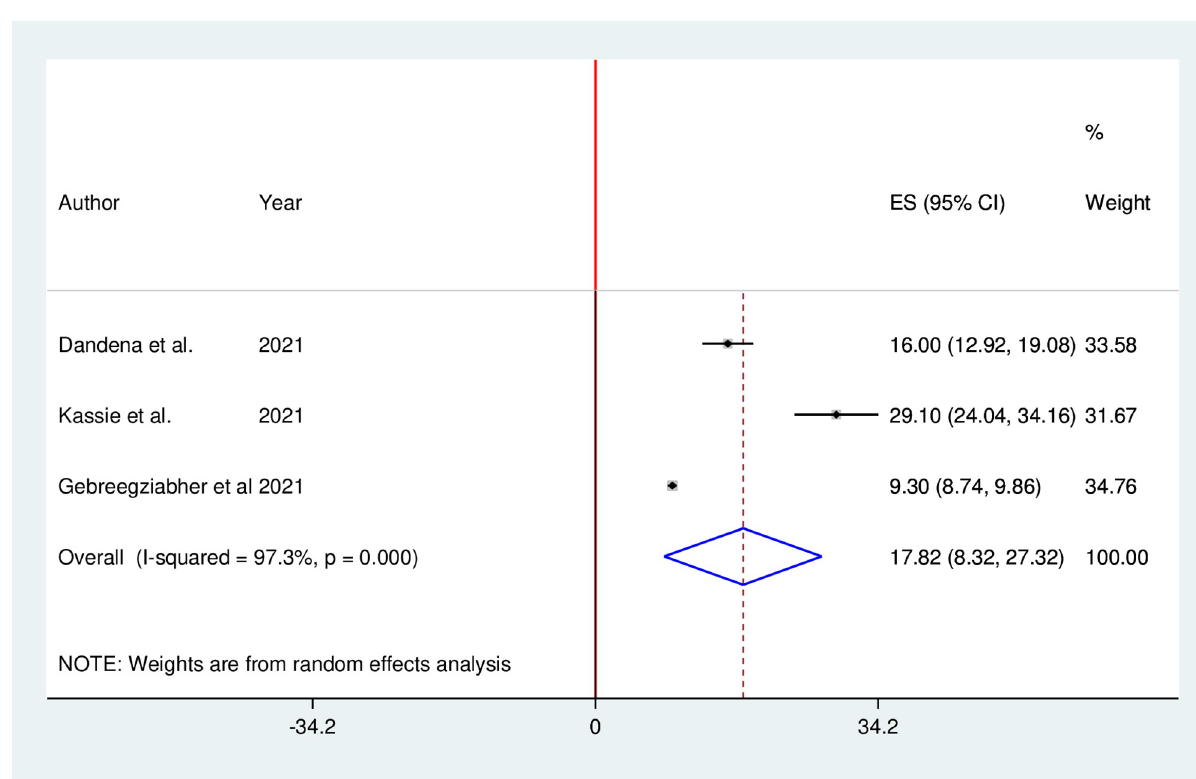
Fig 11. Forest plot of the pooled reduction of postnatal care services utilization during COVID-19 pandemic in Ethiopia, 2021.